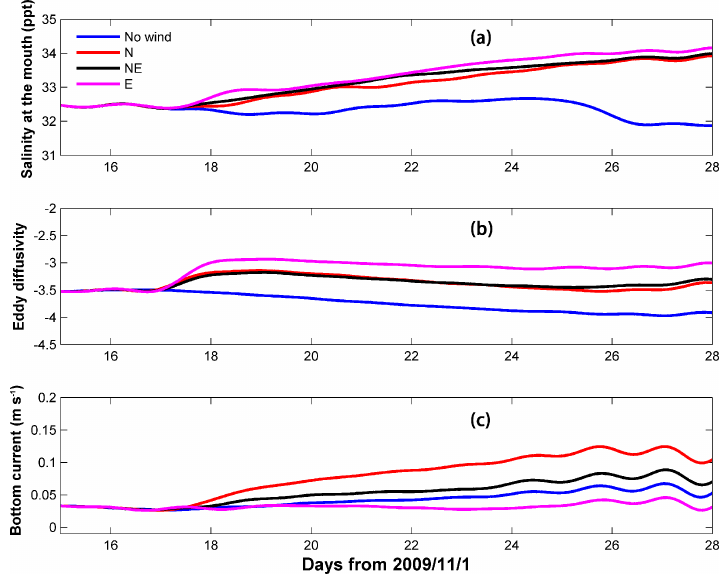
Figure 16. Panel (a) low-pass filtered vertically-averaged salinity at the estuary mouth; panel (b) low-pass filtered log 10 of mean eddy diffusivity along the longitudinal transect T1; panel (c) low-pass filtered mean bottom current along the